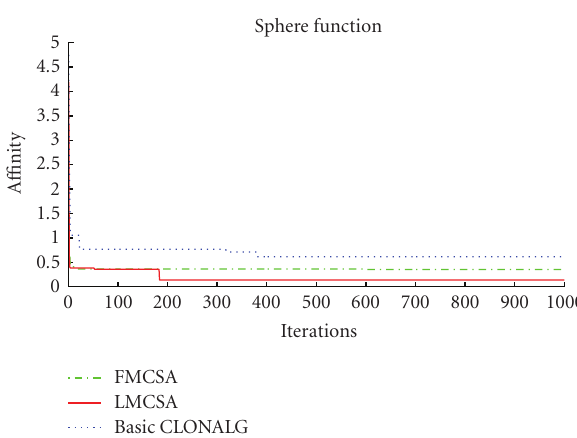
Figure 3: Convergent performances on sphere function ( f 1).